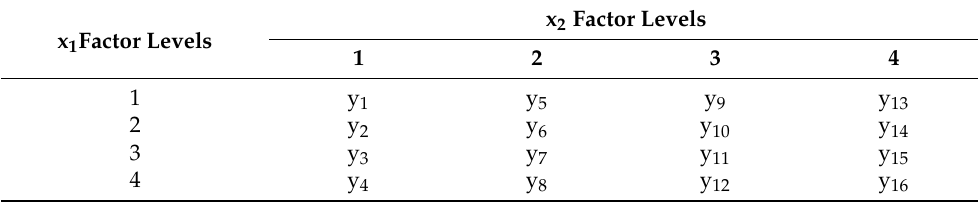
x 2 Factor Levels